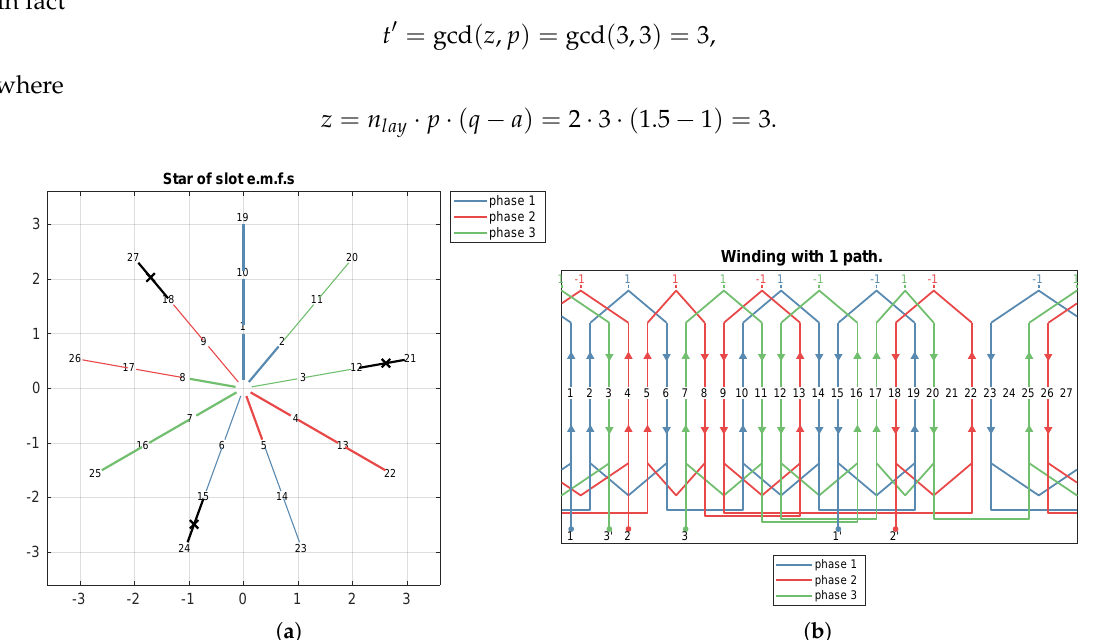
Figure 6. ( a ) Slot EMF star for a symmetrical single-layer coil winding and ( b ) winding scheme. N = 27, m = 3, p = 3, Q = 1 + 1 / 2 and q = 2.